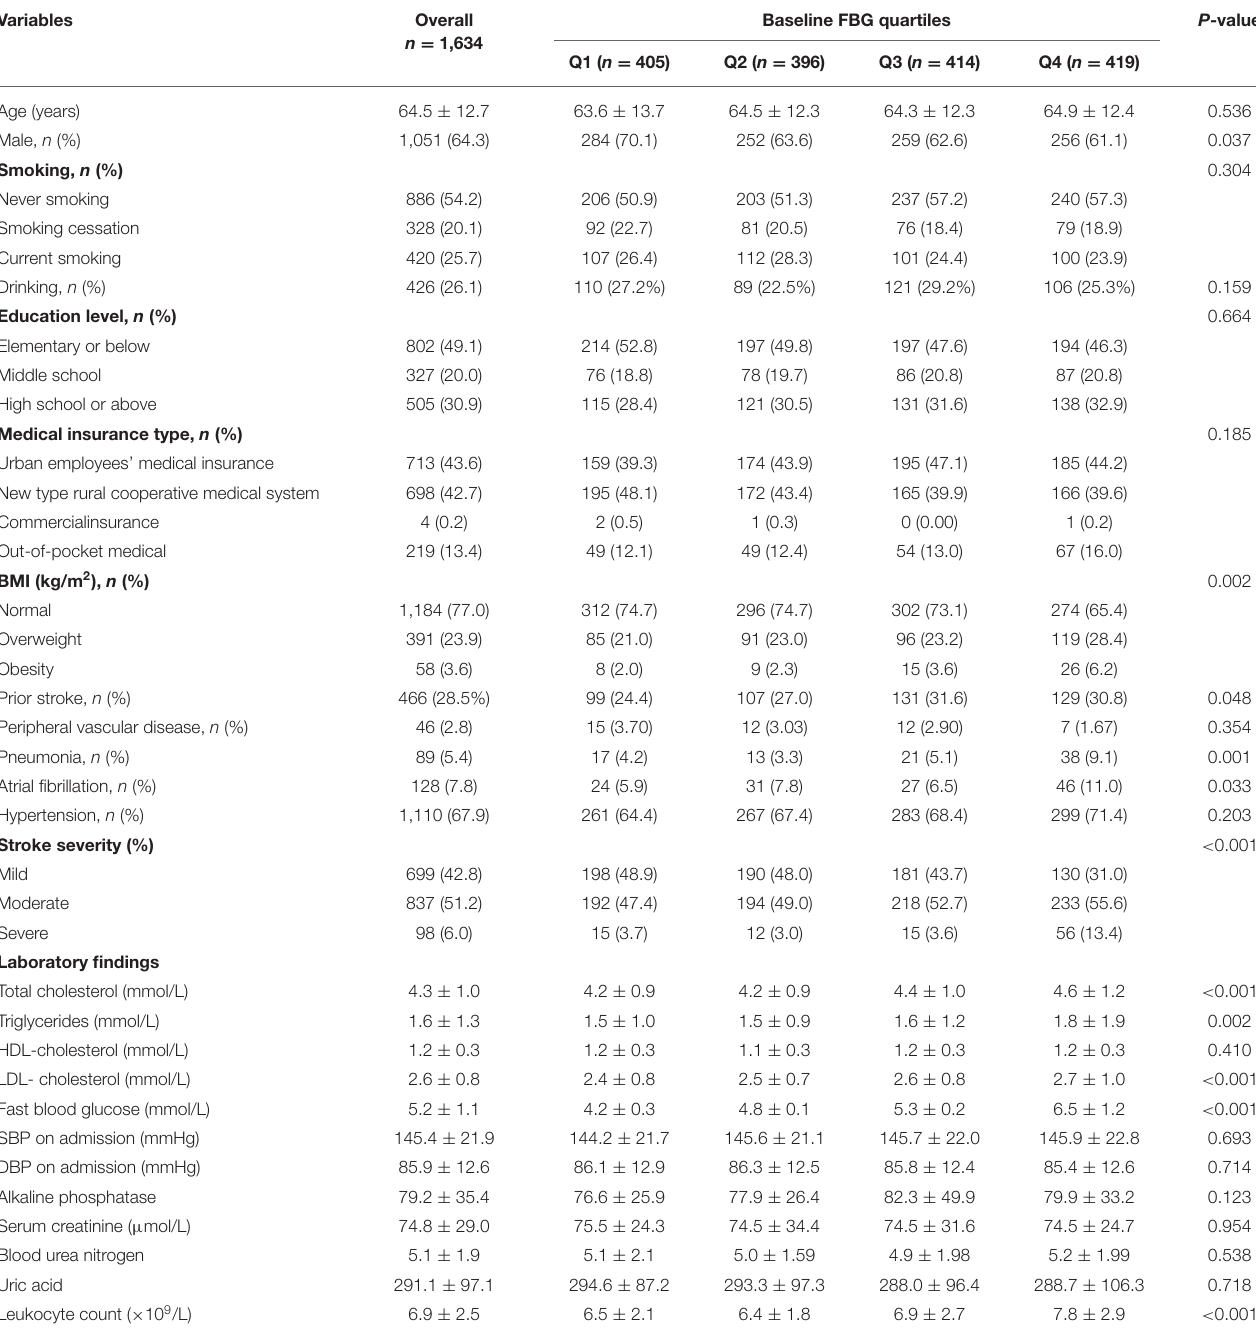
TABLE 1 | Baseline and biochemical characteristics by baseline fasting blood glucose (FBG) quartiles in non-diabetes patients with acute cerebral infarction (ACI).